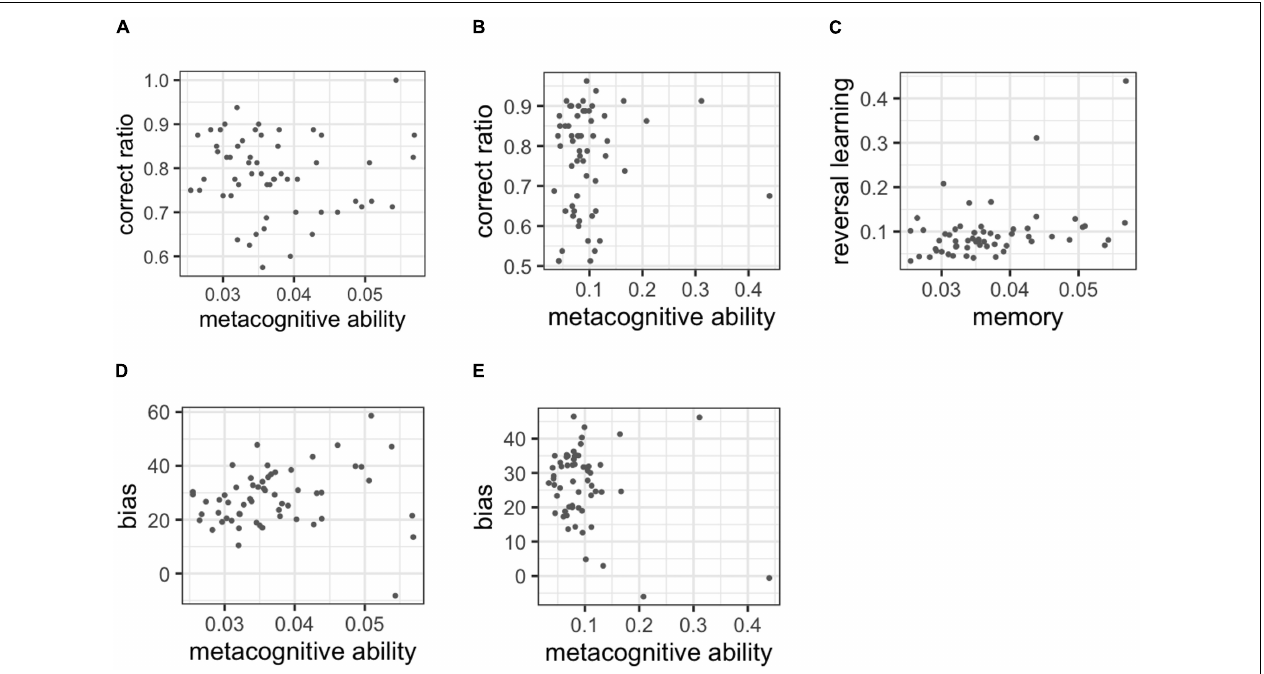
FIGURE 8 | (A) Correlations between the correct ratio and metacognitive ability in the memory task, (B) correlation between the correct ratio and metacognitive ability in the reversal learning task, (C) correlation with metacognitive ability between tasks, (D) correlations between metacognitive ability and bias in the memory task, (E) correlations between metacognitive ability and bias in the reversal learning